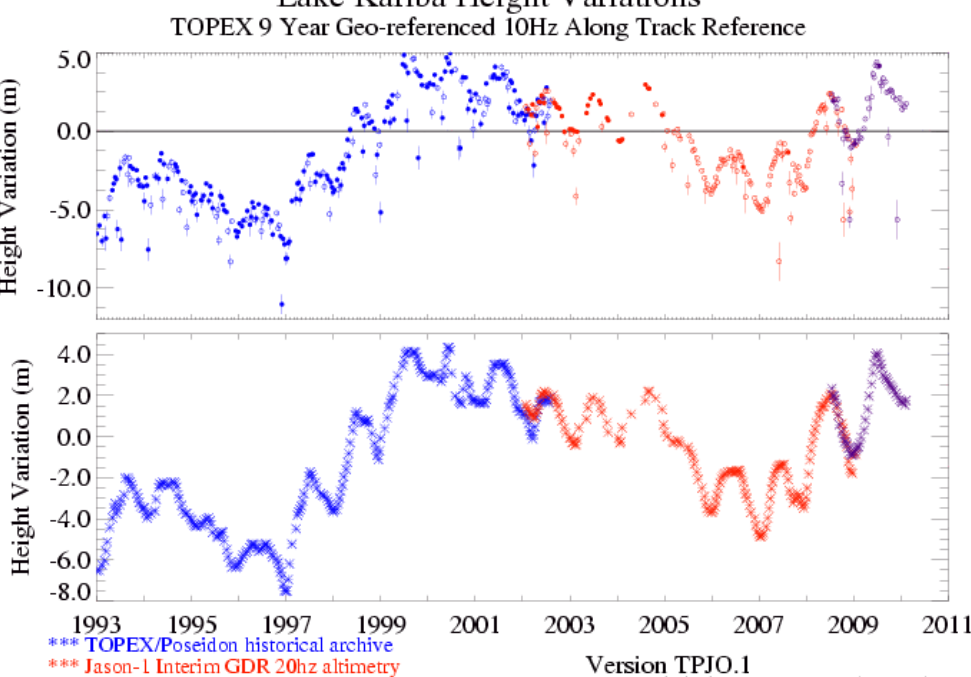
Figure 9. Time series of lake level variations for Lake Kariba, Zambia, derived from satellite radar altimeter observations, blue (Topex/Poseidon), red (Jason-1), purple (Jason-2/OSTM) for the 1993–2010 period. Lower plot depicts a filtered version of the actual results (top) for visual inspection